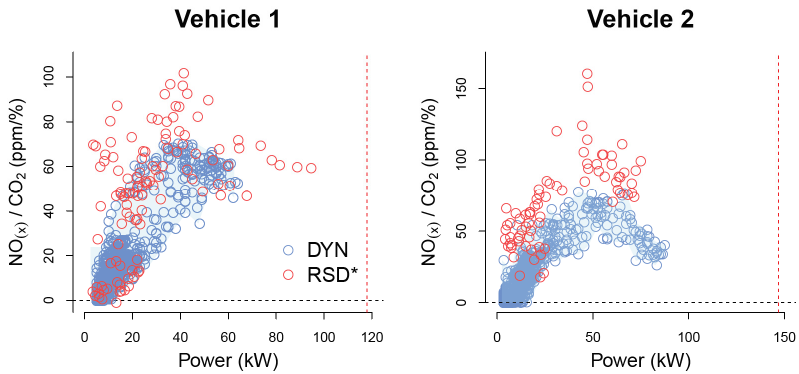
Figure 10. Dynamometer and RSD speed, power and hot running emissions data (assuming fNO 2 is is zero).